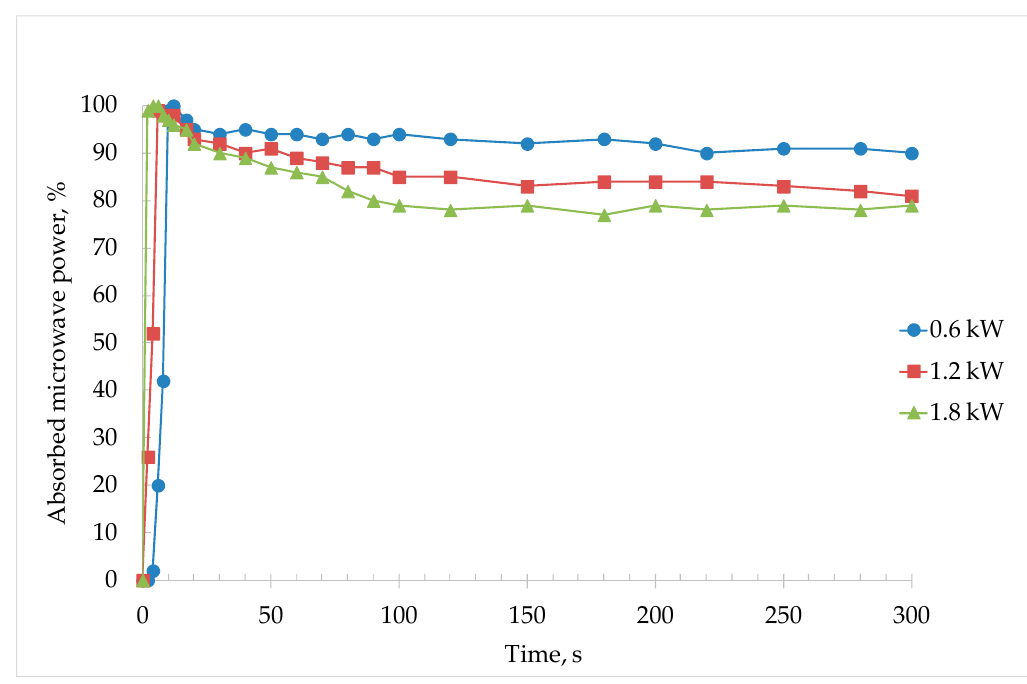
Figure 3. Percentage of the absorbed microwave power from bauxite residue (BR), mixed with metallurgical coke (C/BR 0.180), by choosing three different power capacities, 0.6 kW, 1.2 kW and 1.8 kW at a 1 L/min N 2 flow constant for 5 min.